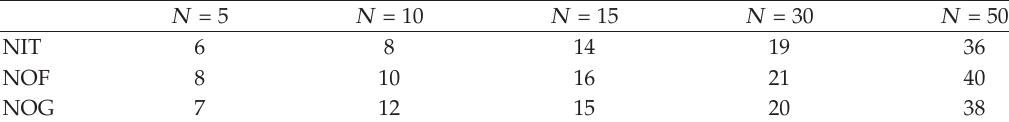
Table 4: Numerical results of Example